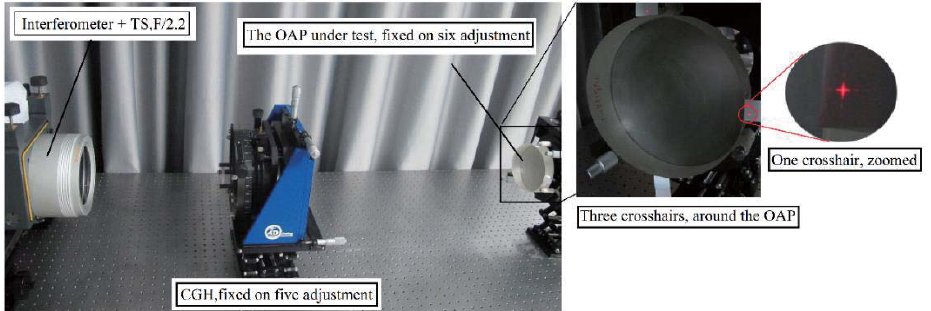
Figure 8. Photo of measuring the OAP with the single CGH method.